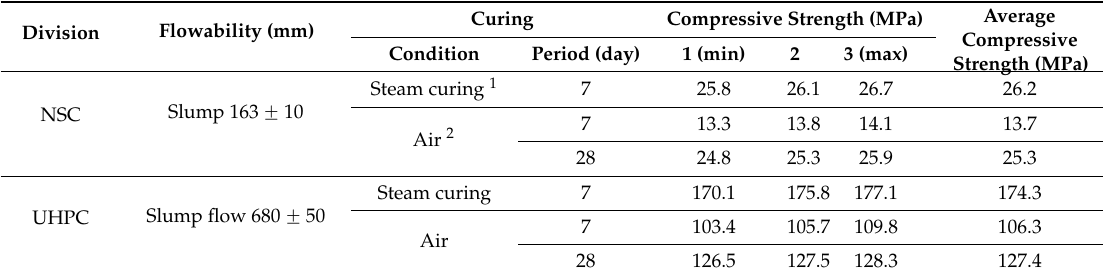
Table 7. Results of compressive strength